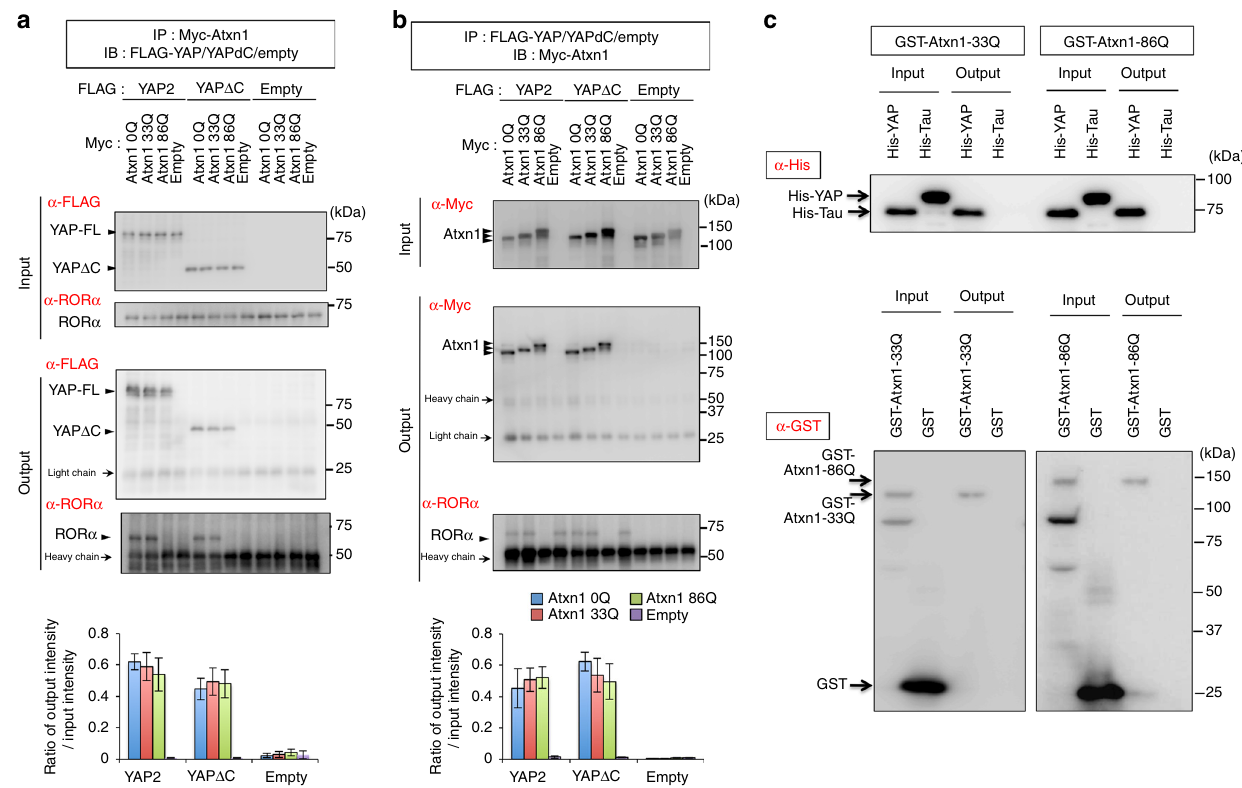
Fig. 4 Formation of the protein complex containing ROR α , YAP, and Atxn1. a , b Immunoprecipitation analyses were performed with transient transfection of FLAG-YAP2/YAPdeltaC and Myc-Atxn1-0Q/33Q/86Q in primary cerebellar neurons at 2 days after transfection. The lower graphs show quantitative analyses of the relative intensities of output band, corrected based on the corresponding input band ( n = 3). Double asterisks: p < 0.01 in one-way ANOVA with post hoc Tukey ’ s HSD test. c Pull-down assay to test for a direct interaction between YAP and Atxn1-33/86Q. GST-Atxn1 and His-YAP were incubated and pulled down with glutathione – Sepharose (upper panel) or His-resin (lower panels). Pulled-down and interacting proteins were detected with anti-His or anti-GST (Fig. 2b), in consistence with the late-onset effect of ROR α - mediated transcription reported previously 12 , and suggested functional interaction between YAPdeltaC and ROR α .